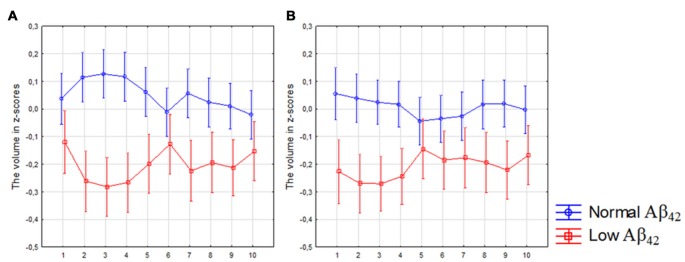
Differences in subicular volume between cases with normal and low cerebrospinal fluid (CSF) Aβ42 levels. The figure denotes differences in subicular volume segment in participants with low (red line) and normal (blue line) levels of Aβ42 in all participants. The x-axis denotes volume segment from posterior (segment 1) to anterior (segment 10). The y-axis denotes the volume of segment normalized as z-scores. (A) left side, (B) right side. Analysis is controlled for gender, intracranial volume and age. Vertical bars denote 95% confidence interval.